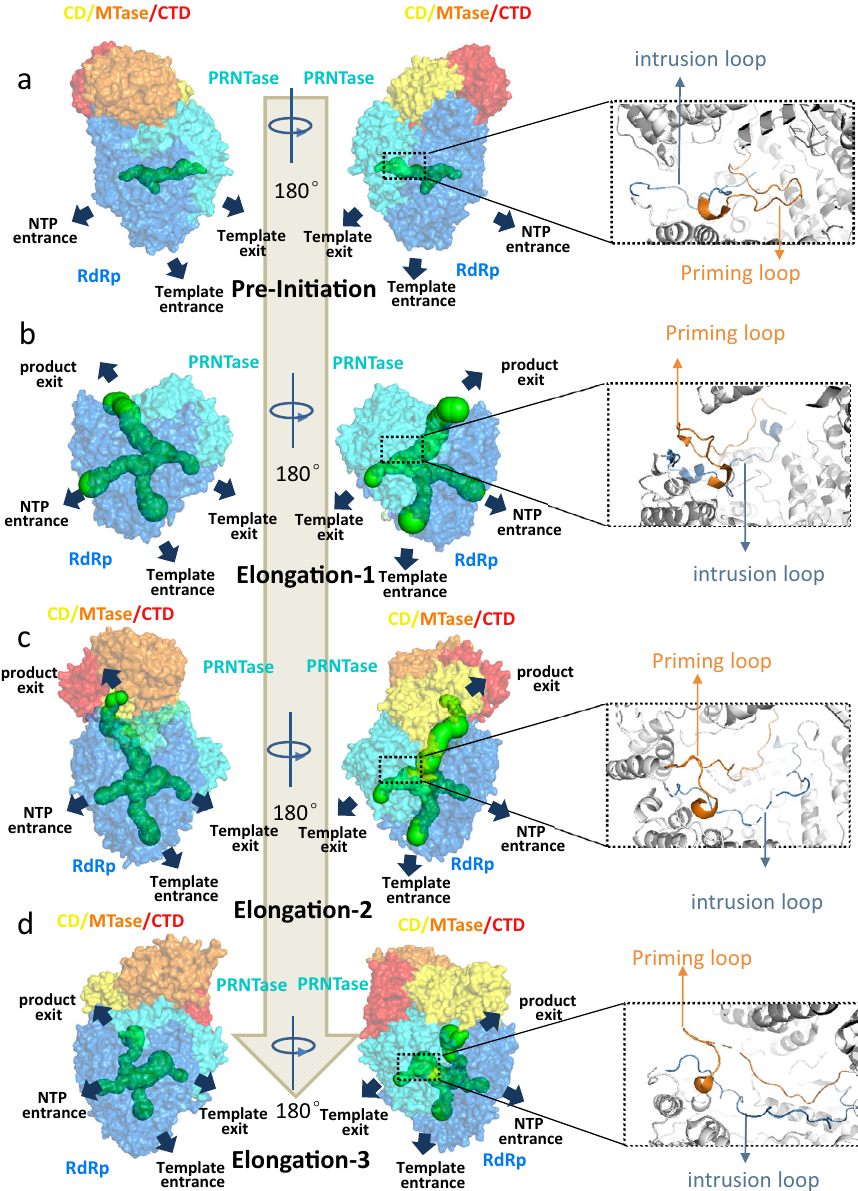
Fig.7|ModelofinitiationandelongationforL-PcomplexinRNAsynthesis.a In